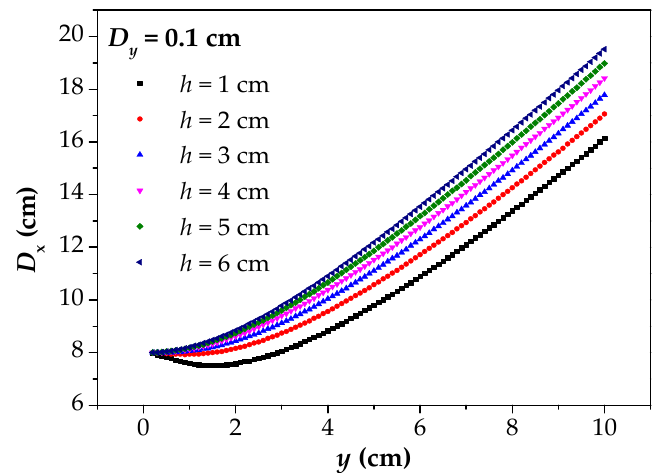
Figure 9. When D y is 0.1, the calculated results of D x under different h . D x : the intersecting point distance between curves of magnetic flux component of x direction at different lift off heights; h : the depth of corrosion defect; D y : the difference between two lift off heights; y : the lift off height.